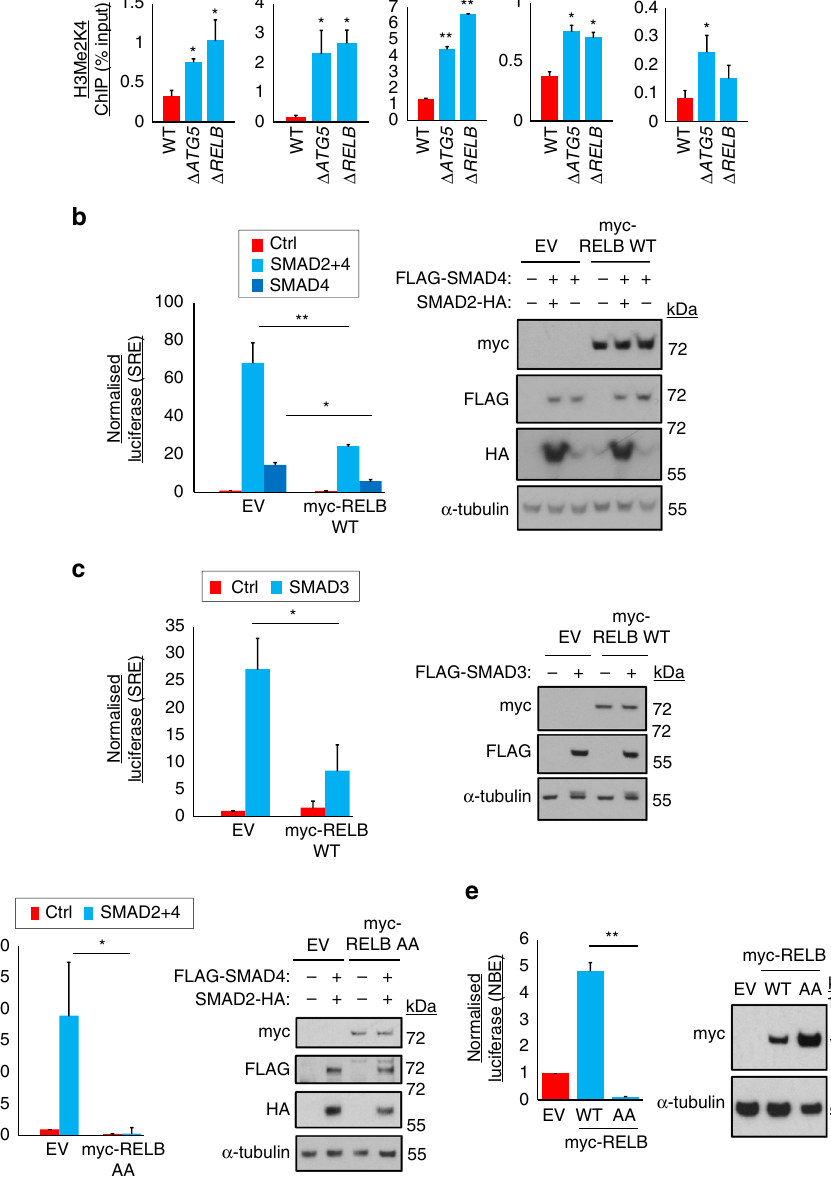
Fig. 6 Autophagy/RELB suppress activation of TGF β gene promoters independent of NF- κ B binding elements. a WT, Δ ATG5 and Δ RELB A549 cells were subjected to chromatin immunoprecipitation (ChIP) for dimethyl-K4-histone H3 (H3Me2K4). Precipitating proximal promoter DNA was quanti fi ed by qRT- PCR, expressed as a percentage of input (means, n = 3, ± S.D., * P < 0.05 or ** P < 0.01 vs. WT cells, two-tailed t -test). Gene names are shown above the charts. b – e HEK239T cells were co-transfected for 30 h with a fi re fl y luciferase reporter driven by b – d a SMAD-response element (SRE) or e an NF- κ B binding consensus element (NBE), and a constitutive Renilla luciferase control plasmid, along with expression vectors for the indicated forms of epitope- tagged RELB (wild-type, WT, or R141A Y142A, AA), SMAD2, SMAD3 and/or SMAD4 or an empty vector (EV) control. Luciferase assays were then performed as described in Methods ( left , fi re fl y/ Renilla ratios expressed in arbitrary units, means, n = 3, ± S.D., * P < 0.05 or * P < 0.01 vs. EV, two-tailed t -test). Immunoblotting was performed to assess transfected factor expression for each replicate ( right , representative blots). Uncropped blots are available in Supplementary Fig.